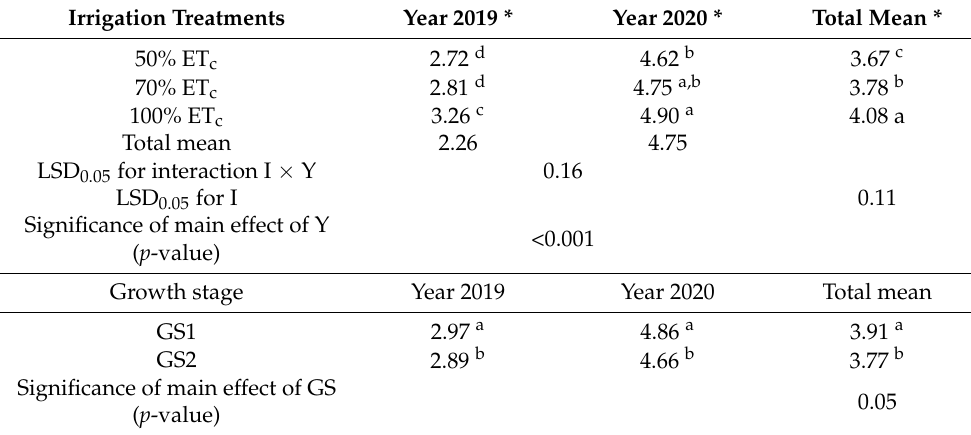
Table 4. Leaf area index (LAI) for the two years 2019 and 2020, for two growth stages. Data presented are mean values, where LSD 0.05 is the Least Significant Difference at the 0.05 significance